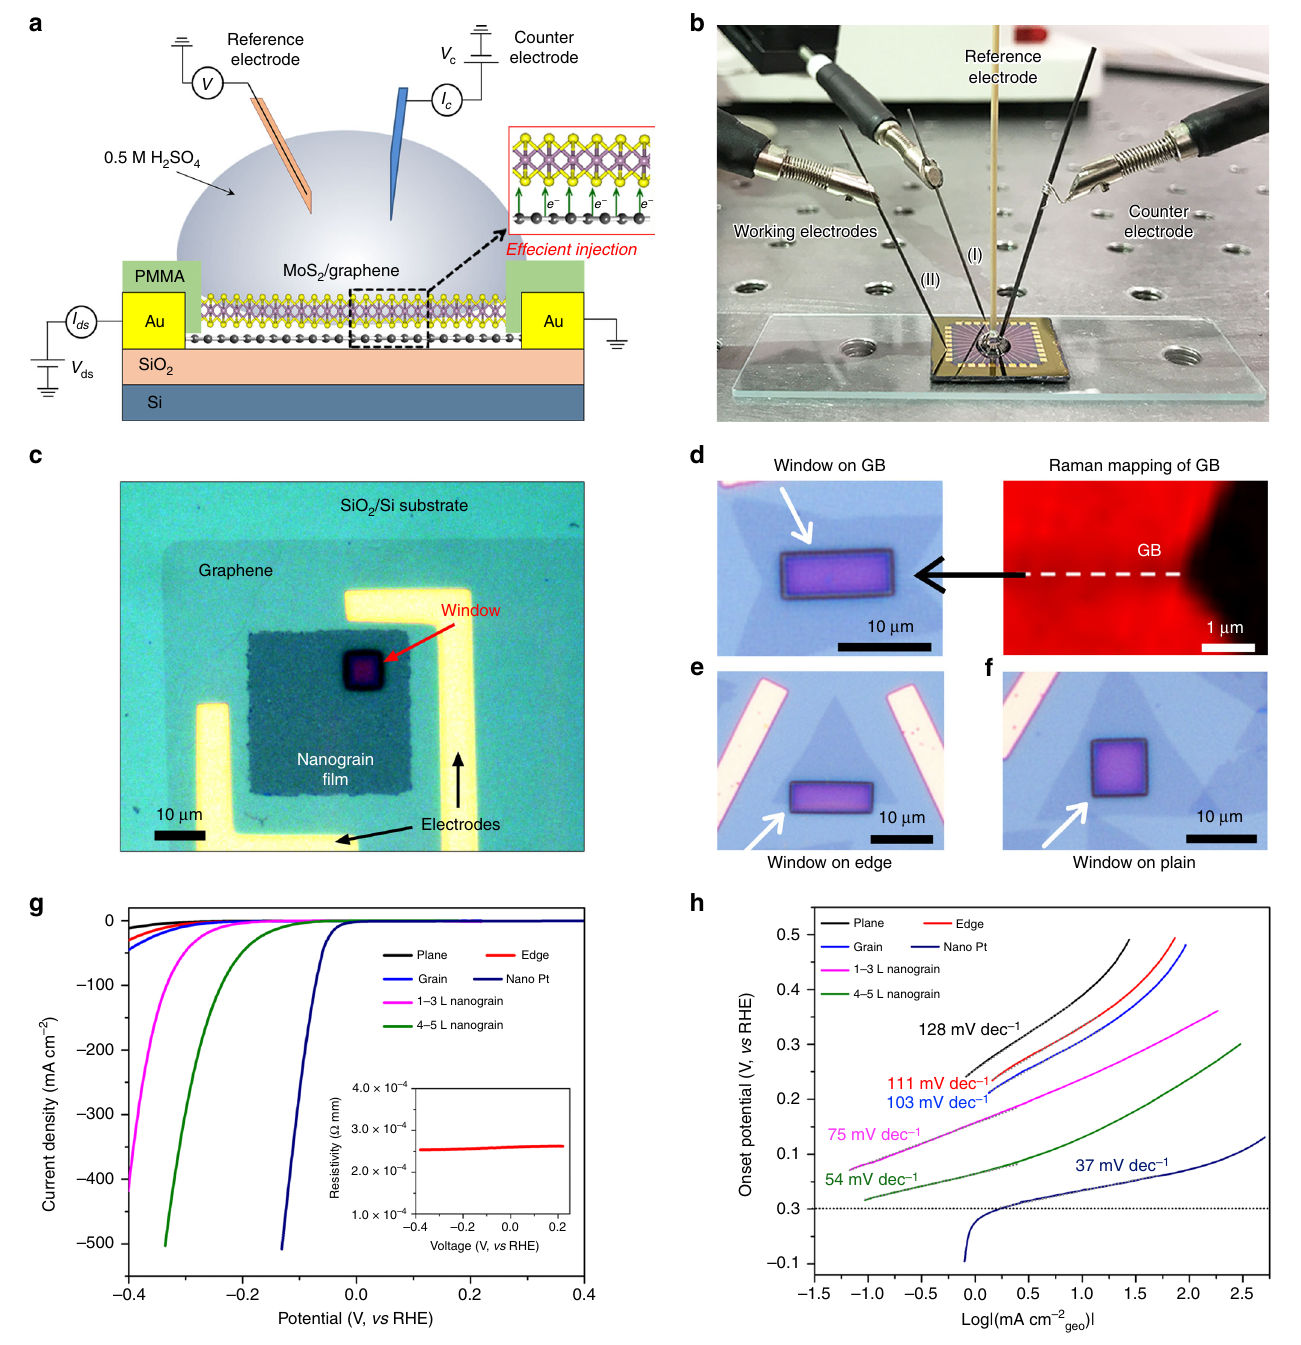
Fig. 5 Micro-electrochemical cell-based HER activity of a MoS 2 nanograin fi lm. a Schematic of the micro-electrochemical cell for HER measurements, where graphene serves as a vertical electron injector. b Photograph of the micro-electrochemical cell. c Optical images of the MoS 2 nanograin device, consisting of a PMMA reaction window, a MoS 2 nanograin fi lm, a graphene supporting layer, and a SiO 2 /Si substrate from top to bottom. d – f Optical images of the MoS 2 devices with a single GB ( d ), a single edge ( e ), and basal plane ( f ), respectively. In these devices, the HER process occurs at the exposed widows on the PMMA passivation fi lm as indicated by the white arrow. g , h Polarization curves of the current density ( g ) and the corresponding Tafel plots ( h ) of the MoS 2 devices. The window size is ~80 μ m 2 for each